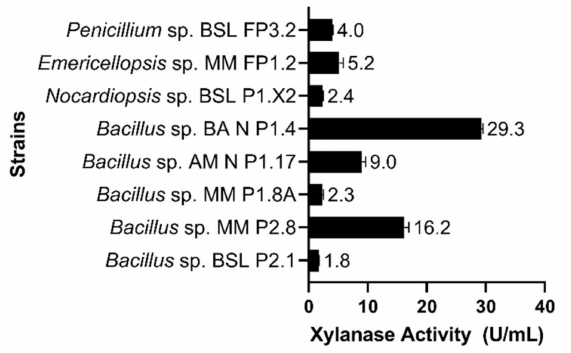
Figure 8. Xylanase activities, expressed in units per mL, in the culture supernatant. The results are presented as averages of three replicates; error bars represent the standard deviation of the